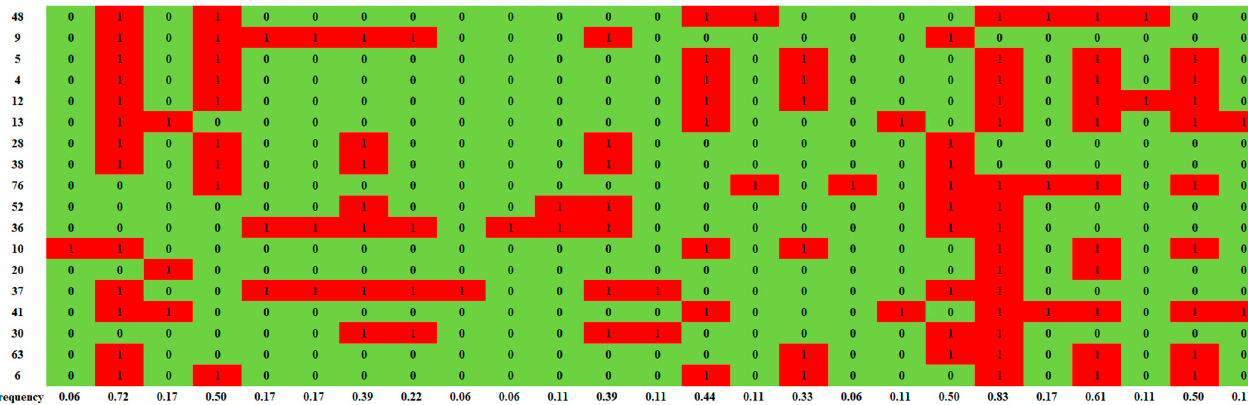
Figure 4. Structure fingerprint of d-Limonene group. PO, pi-orbitals; Ak, alkyl; HD, H-donor; HA, H-acceptor; Sf, sulfur.